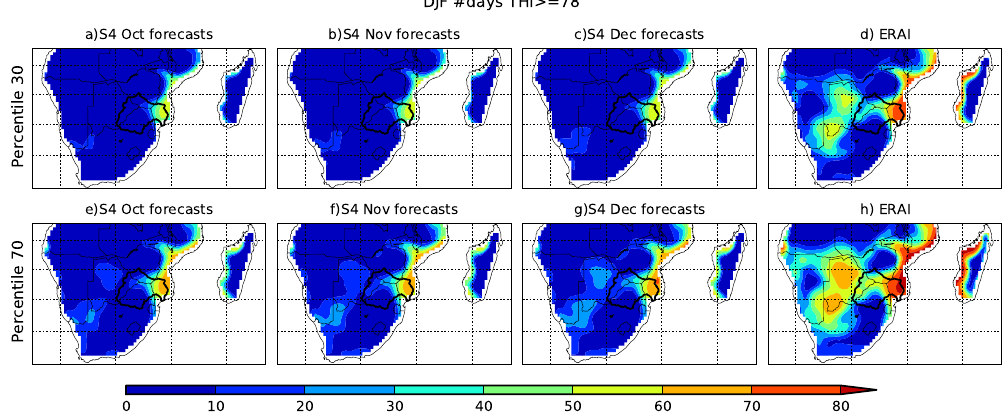
Fig. 5. Same as Fig. 4 but the climatology of DJF frequency of occurrence of days with THI higher than 78.